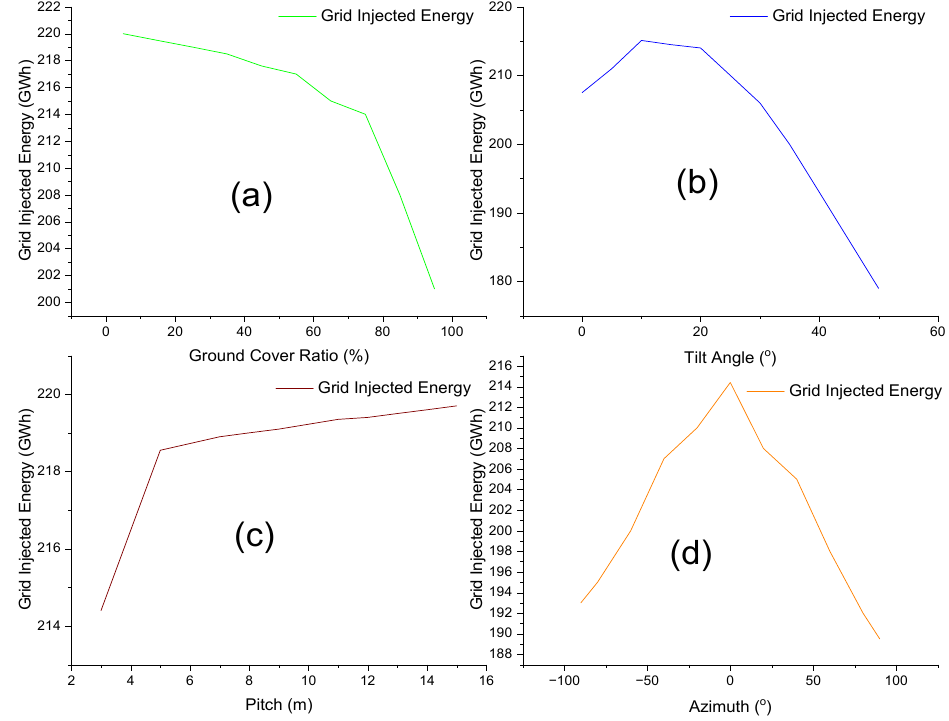
Figure 16. ( a ) Optimization of injected energy vs. ground cover ratio. ( b ) Energy vs. panel tilt angle. ( c ) Energy vs. pitch in meters. ( d ) Injected energy vs. azimuth angle. Table 5. Table showing the cost and energy production distribution (cost breakdown sources [130,131]).